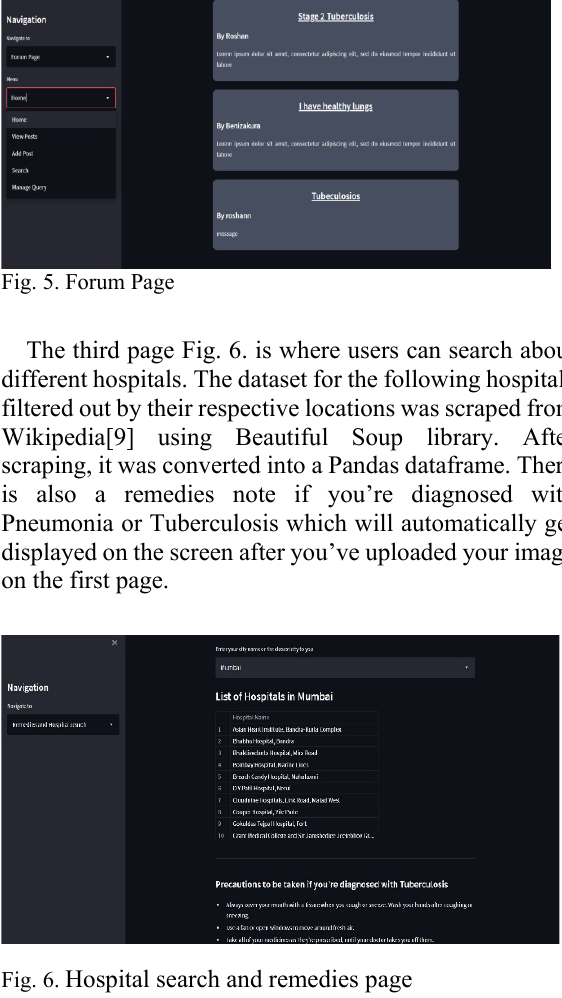
Fig. 6. Hospital search and remedies